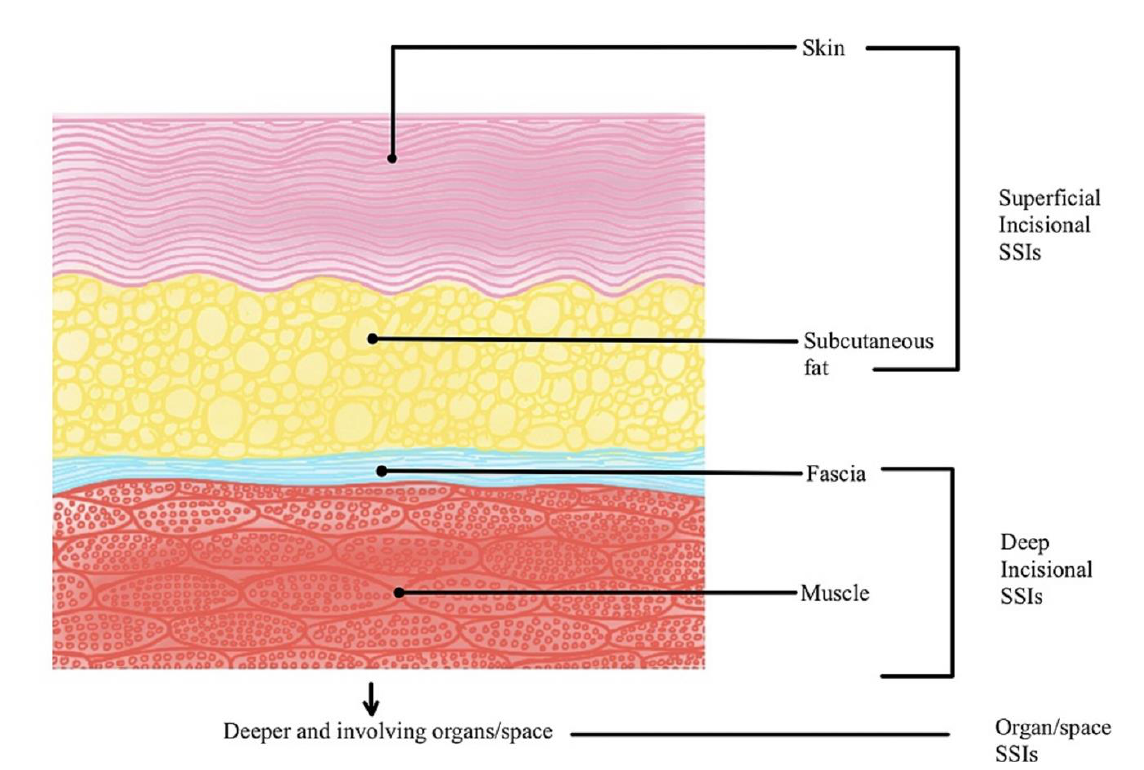
Figure 1: Classification of Surgical Site Infections (SSIs). Picture courtesy: Kannan et al.